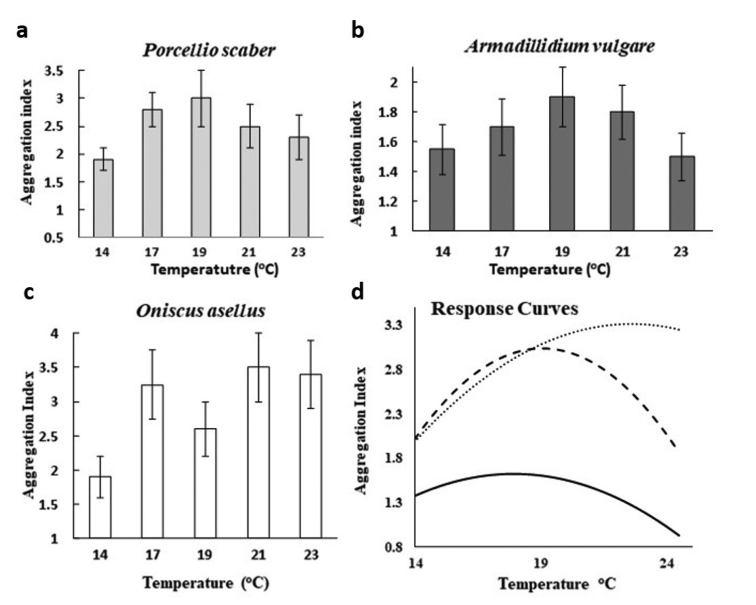
Aggregation of isopod species differing in desiccation resistance at different temperatures. Mean ± 1 SE aggregation indices (variance:mean ratio) at 90% relative humidity. aP.scaber (F 4,249 = 3.76, p < 0.01) bA.vulgare (F 4,249 = 1.97, P < 0.01) cO.asellus (F 4, 249 = 12.22, P < 0.001) d thermal reaction norms for aggregation expressed as quadratic response curves for: P.scaber (dashed line): y = -11.519 + 1.526× - 0.04×2; A.vulgare (solid line): y = -3.534 + 0.574× 0.016×2; O.asellus (dotted line): y = -5.890 + 0.814× – 0.018×2.